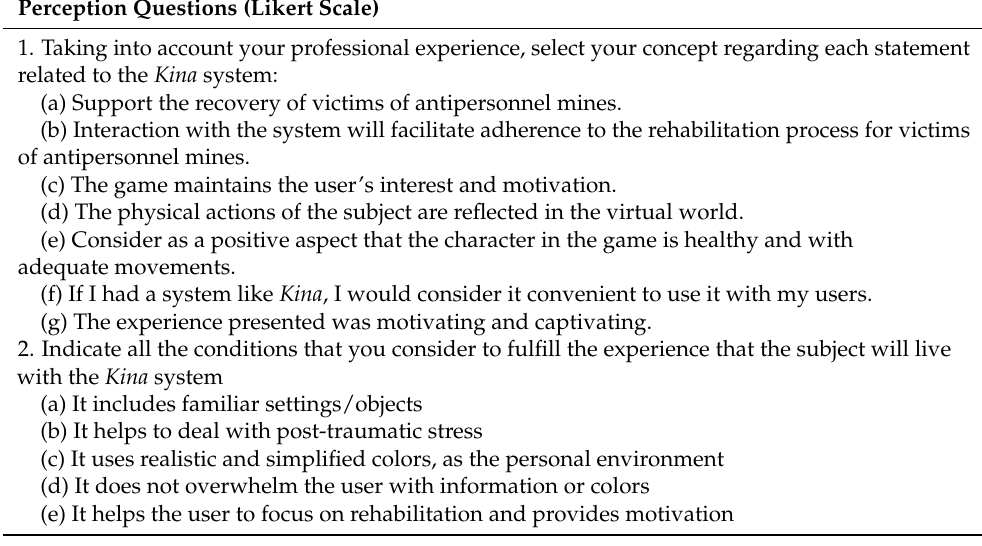
Table 2. Questions about the general perception of the Kina system (Likert scale). Perception Questions (Likert